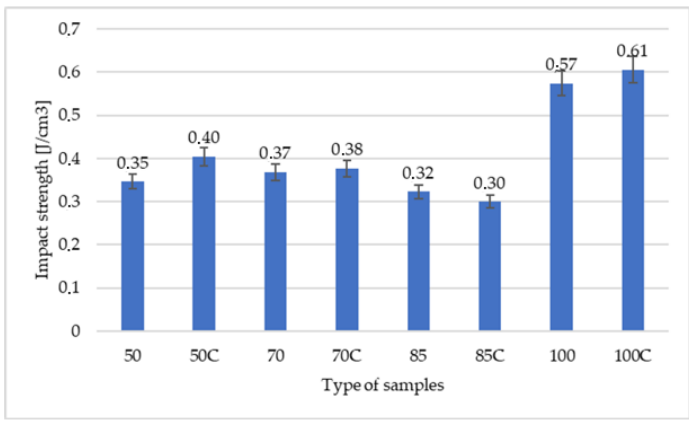
Figure 7. Impact strength depending on the percent of added infill and crystallinity of samples.